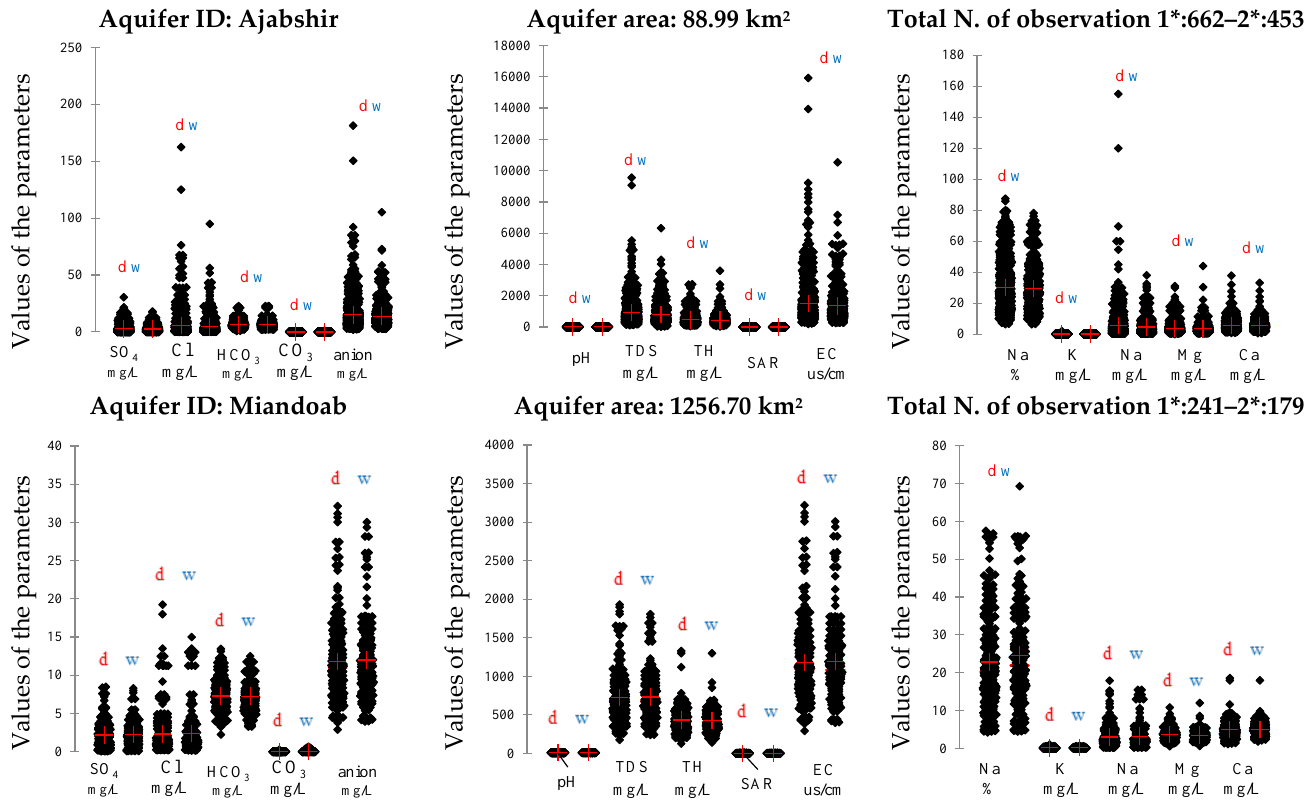
Figure 5. Statistical analysis of the chemical concentrations in the groundwater from nine aquifers on the eastern shore of Lake Urmia. The notation ”d” and “w” refer to the dry and rainy seasons, respectively. Note: SAR, sodium adsorption ratio; TH, total hardness; TDS, total dissolved solids; EC, conductivity.